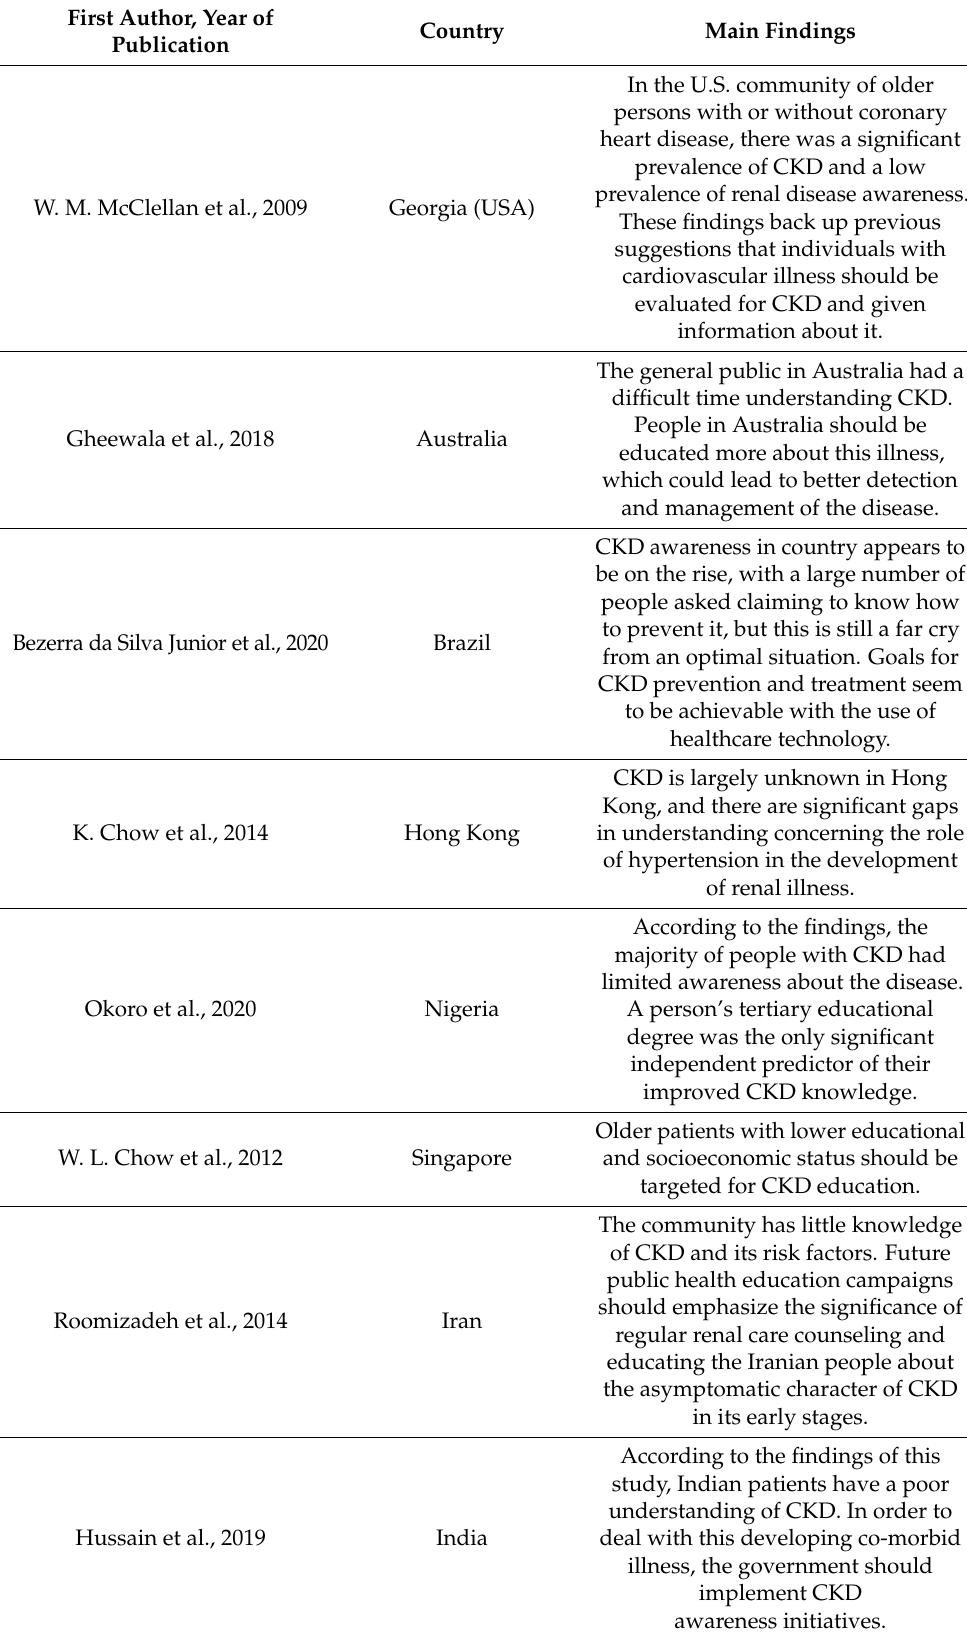
Table 7. Previous findings about CKD knowledge and